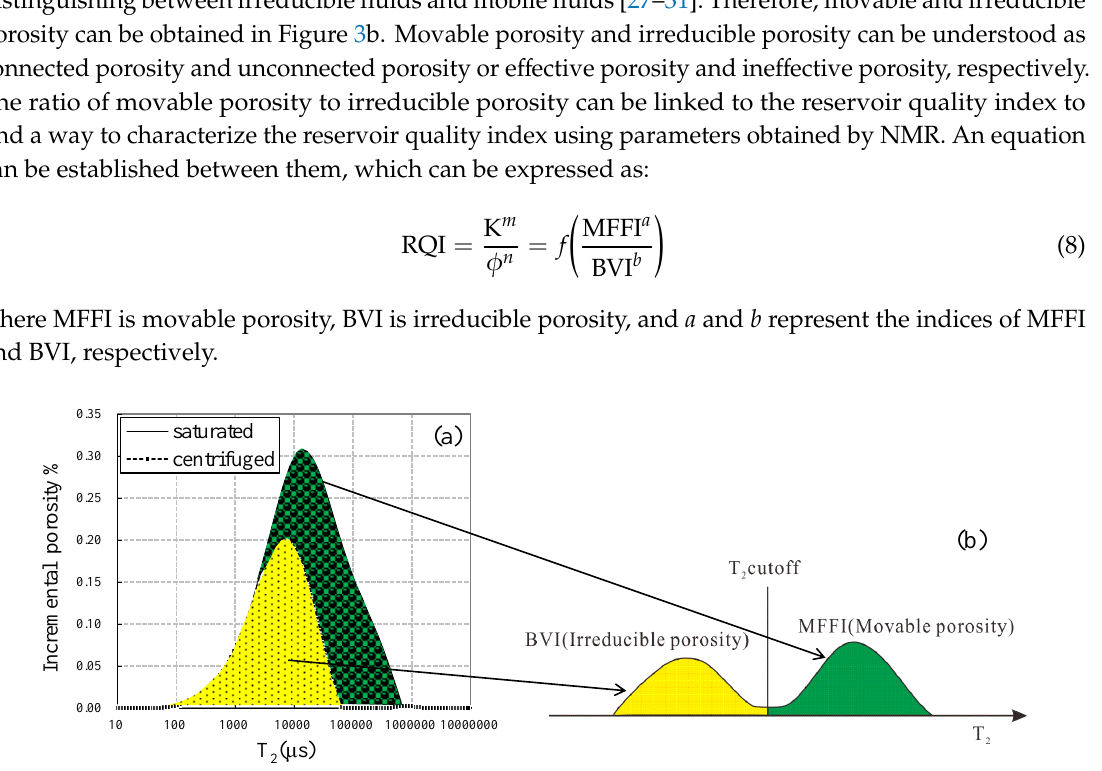
Figure 3. ( a ) The NMR T 2 distributions for sample No. 1, and ( b ) movable (green area) and irreducible (yellow area) porosity of sample No.1.